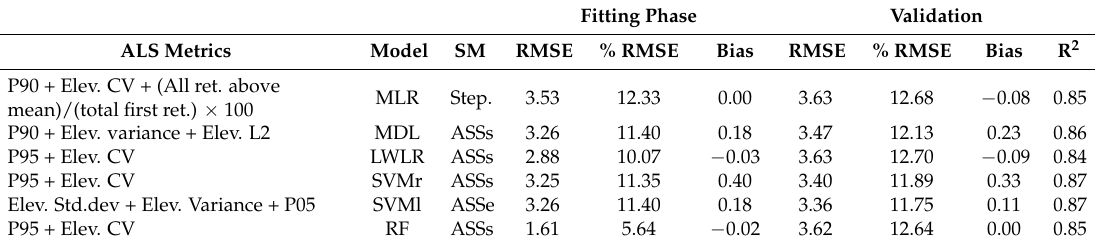
Table A9. Summary of the Do models using 2016 ALS data. Validation results in terms of RMSE (cm), %RMSE, and bias (cm) and R 2 . SM refers to selection method; Step. stands for Stepwise both and forward; SVMr. refers to support vector machine with radial kernel; SVM l. refers to support vector machine with linear kernel; ret. refers to returns.